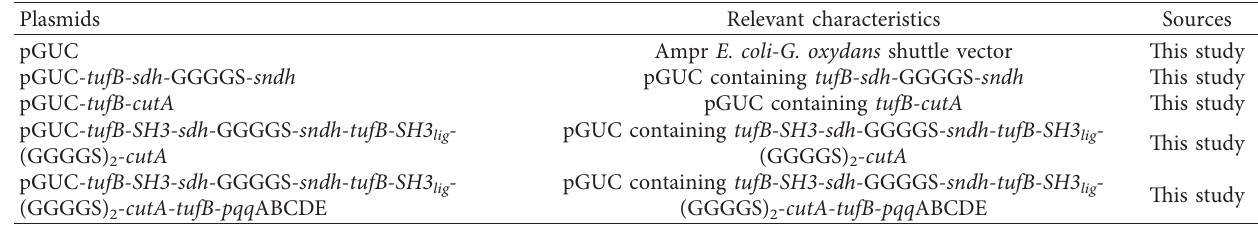
Table 1: Plasmids used in this